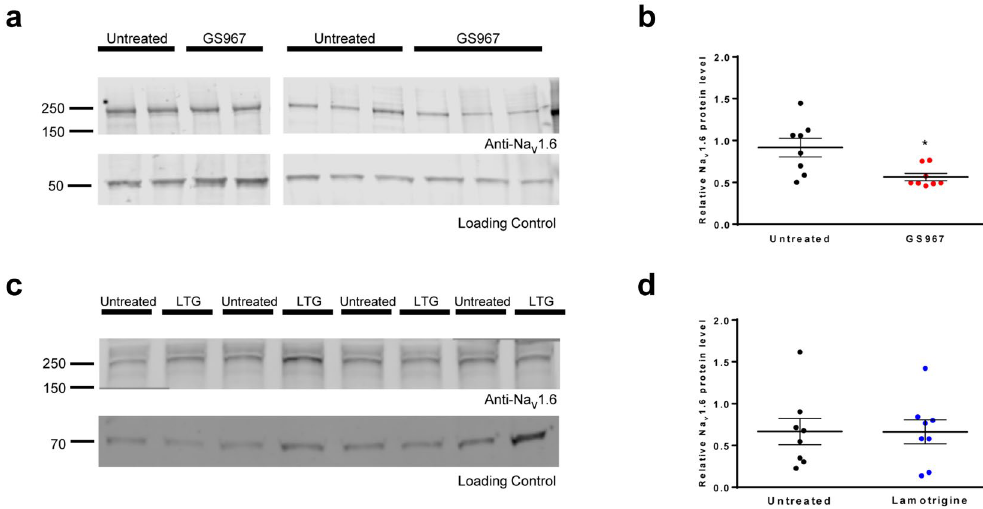
Figure 5. GS967 reduces neuronal Na V 1.6 expression in Scn1a + / − mice. ( a ) Western blot analysis of Na v 1.6 protein levels in hippocampal membrane preparations from Scn1a + / − mice. Representative blots of five biological replicates are shown for untreated and GS967-treated mice. ( b ) Scatter plot of densitometric analysis of Western blot data. Data points represent the average densitometry ( ≥ 2 technical replicates) for individual untreated or GS967-treated mice. The average densitometry values are depicted by the thick black line. Error bars represent SEM, with n = 2–8 mice per group ( * p < 0.016; Student’s t-test). ( c ) Western blot analysis of Na V 1.6 protein levels in hippocampal membrane preparations from Scn1a + / − mice. Representative blot from four biological replicates are shown for untreated and lamotrigine-treated mice. ( d ) Scatter plot of densitometric analysis of Western blot data. Data points represent the individual densitometry for untreated or lamotrigine- treated (LTG) mice. The average densitometry values are depicted by the thick black line. Error bars represent SEM, with n = 8 per treatment. There is no significant difference between groups. Images were cropped to improve conciseness and full length western blot images are presented in Supplemental Fig.